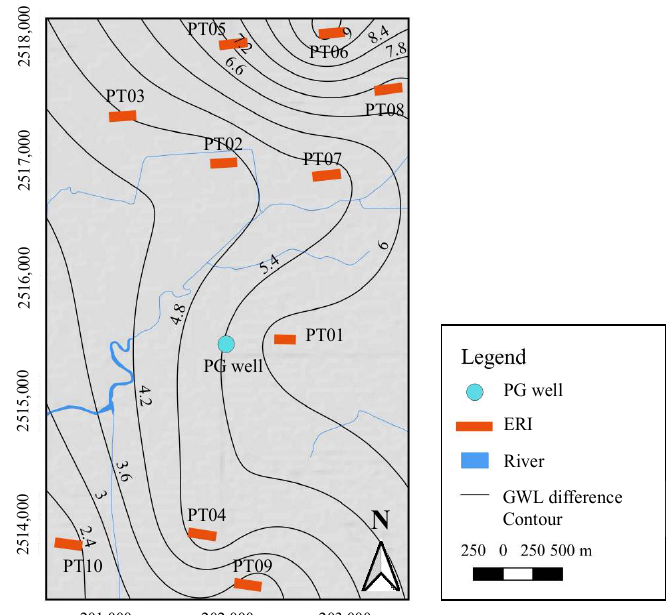
Figure 15. The spatial distribution of the Van Genuchtan groundwater level difference for the wet (September) and dry (April) seasons.